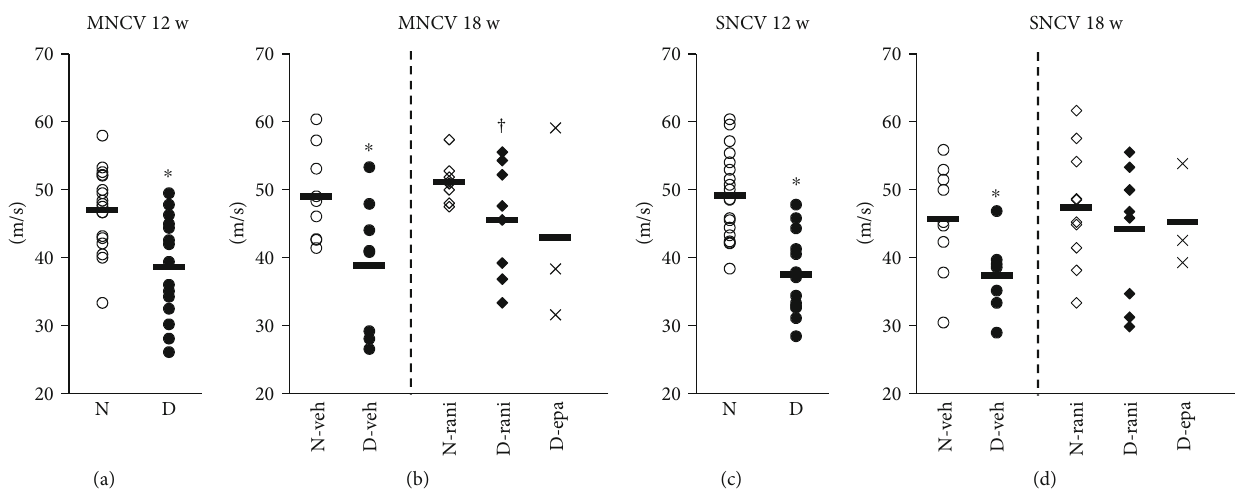
Figure 1: Amelioration of nerve conduction velocities in hindlimbs of diabetic rats treated with ranirestat. Nerve conduction velocities decreased in the diabetic rats 12 weeks after induction of diabetes (a, c). The decrease was diminished in the diabetic rats after 6-week treatment with ranirestat (b, d). MNCV: motor nerve conduction velocity; SNCV: sensory nerve conduction velocity; 12 w: 12 weeks after induction of diabetes; 18 w: 18 weeks after induction of diabetes; N: nondiabetic rats; D: diabetic rats; N-veh: nondiabetic rats treated with placebo; D-veh: diabetic rats treated with placebo; N-rani: nondiabetic rats treated with ranirestat; D-rani: diabetic rats treated with ranirestat; D-epa: diabetic rats treated with epalrestat. ∗ p < 0 : 05 compared with N or N-veh and † p < 0 : 05 compared with D-veh. n = 15~18 at 12 w, n = 8~10 in groups treated with placebo or ranirestat, and n = 3 in D-epa. Bold horizontal line in each group demonstrates an average value.